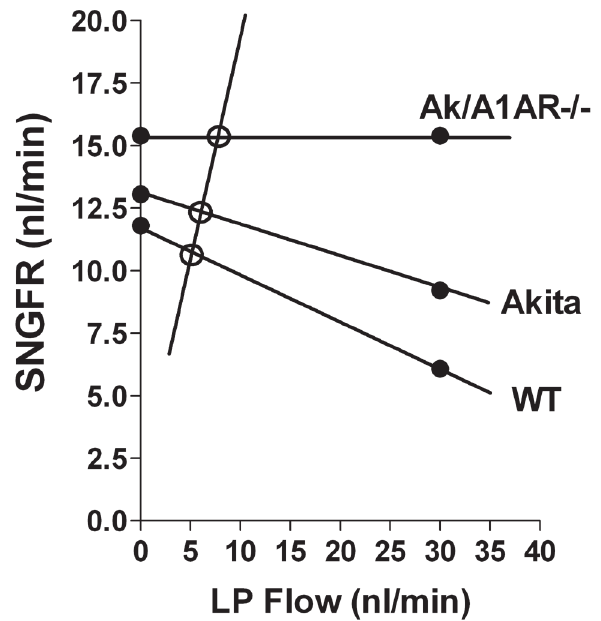
Figure 3. Relationship between the flow rate at the end of the proximal tubule (LP Flow) and SNGFR in wild type (WT), Akita, and Akita/A1AR-/- mice. SNGFR values (black dots) on the y axis represent SNGFR values from the present experiments; SNGFR values at LP flow of 30 nl/min come from our earlier study in which the effect of raising LP flow on early proximal flow rate was determined 9 . The negative lines connecting SNGFRs represent the TGF relationship that, for reasons of simplicity, is drawn as a linear relation, although it is known to be sigmoidal 19,20 . The slope of the positive line reflects proximal reabsorption, and it was calculated assuming a TF/Piothalamate ratio of 2. The intersects between the TGF and reabsorption relationships indicated by the open circles represent steady-state values for reabsorption and SNGFR 19